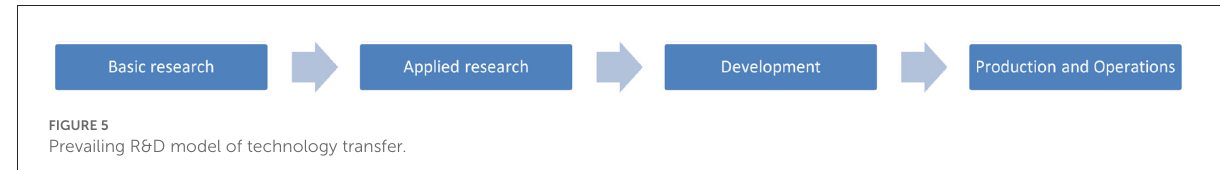
FIGURE5 Prevailing R&D model of technology